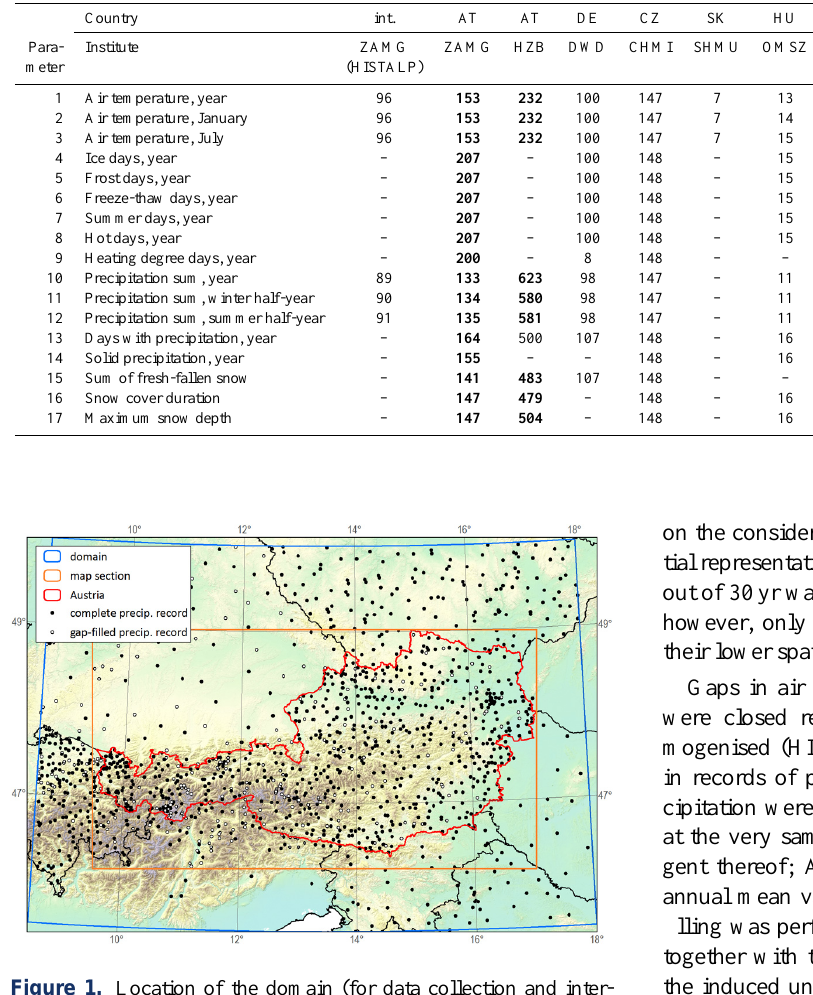
Figure 1. Location of the domain (for data collection and inter- polation) and the map section (for printed products) in relation to the Austrian national borders (for digital products). In addition, the most extensive network of stations with means of annual precipita- tion sum is